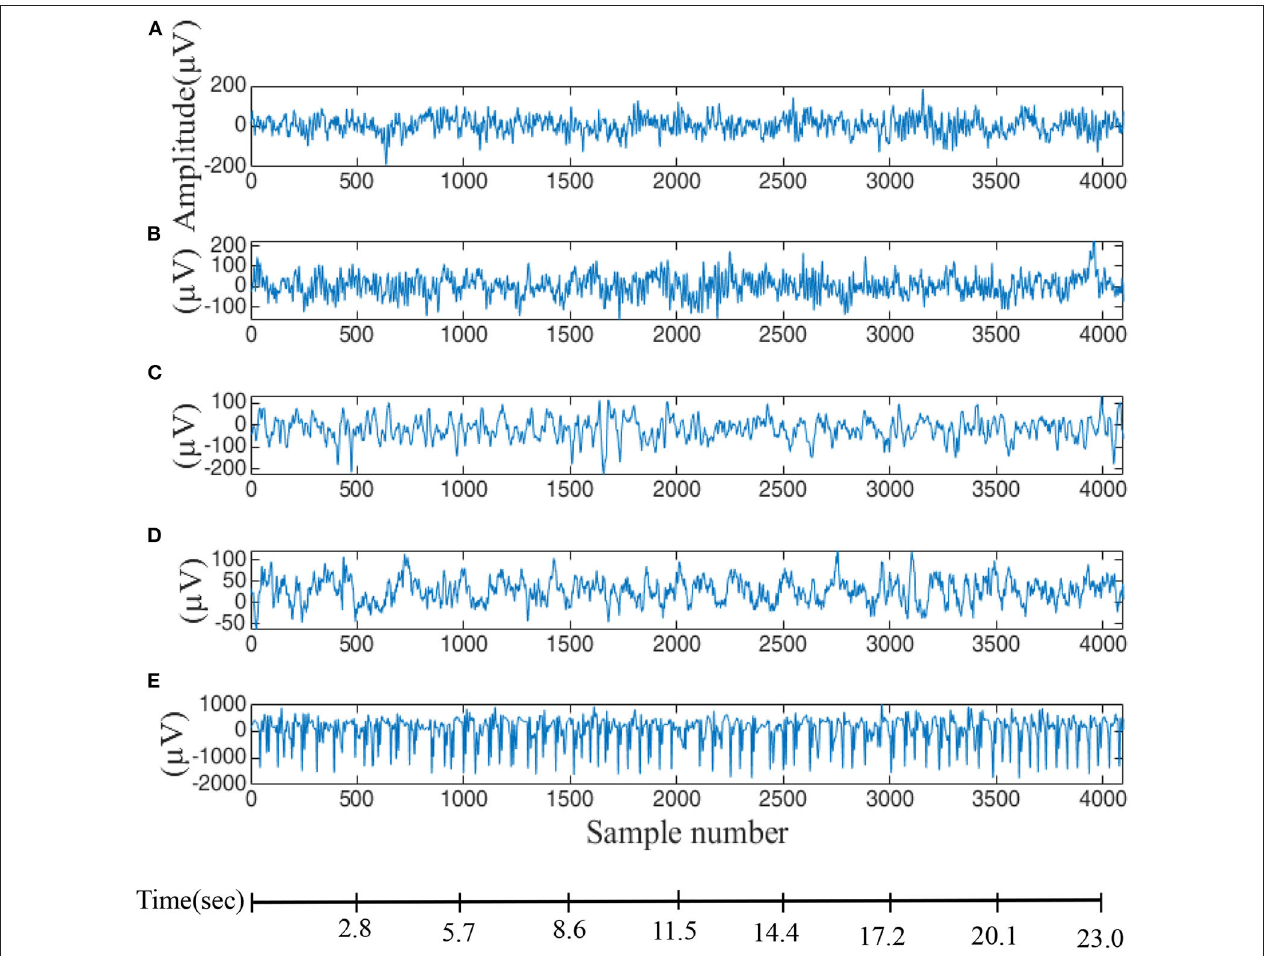
FIGURE 1 | EEG data used for evaluation of difference entropy algorithms. (A,B) Are data from five healthy volunteers with eyes-opened and eyes-closed. (C) Data recorded from patients before an epileptic attack, (D) from the epileptic zone, and (E) during an epileptic